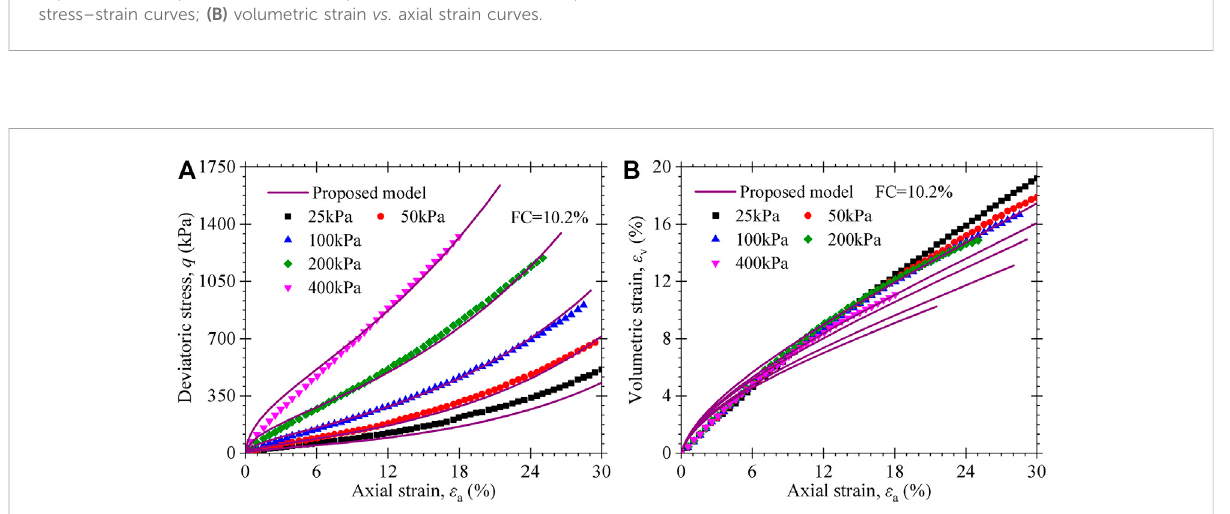
Experimental and predicted triaxial compression test results of MSW specimens with 10.2% fi brous content from Ramaiah and Ramana (2017): (A) stress – strain curves; (B) volumetric strain vs. axial strain curves.